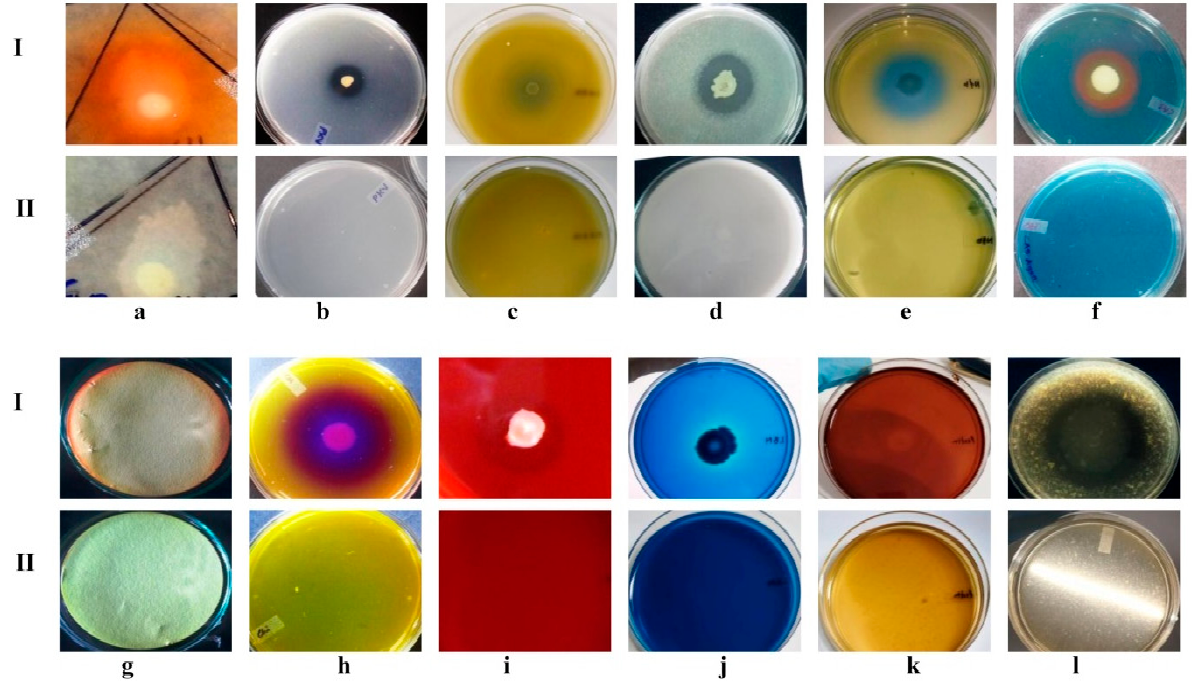
Figure 3. In vitro plant-growth-promoting activities of the bacterial strain A7 on different plate- based agar mediums at 30 ± 2 °C for a particular incubation period in three biological replicates. I = Different PGP activities as ( a ) Indole-3-acetic acid production on Whatman no.1 filter paper in Luria Bertani agar (after one day of incubation), ( b ) Phosphate solubilization on Pikovskaya’s agar, ( c ) Potassium solubilization on modified Aleksandrov agar, ( d ) Zinc solubilization on Zinc Oxide agar (after seven days of incubation period), ( e ) Nitrogen fixation on N 2 free agar (after one day of incu- bation), ( f ) Siderophores production on CAS agar (after three days of incubation) and ( g ) Hydrogen cyanide production (HCN) on glycine agar (after four days of incubation), ( h ) Chitinase production on colloidal chitin agar (after four days of incubation), ( i ) Cellulase production on Congo—red gel- atin agar (after four days of incubation), ( j ) Lignin degradation on Methylene blue indicator MSM— KL agar (after seven days of incubation period), ( k ) Pectinase production on M9 Citrus peel pectin agar (after two days of incubation period), ( l ) Proteases production on Skim milk agar (after seven days of incubation), and II = Control plate of the respective activities.